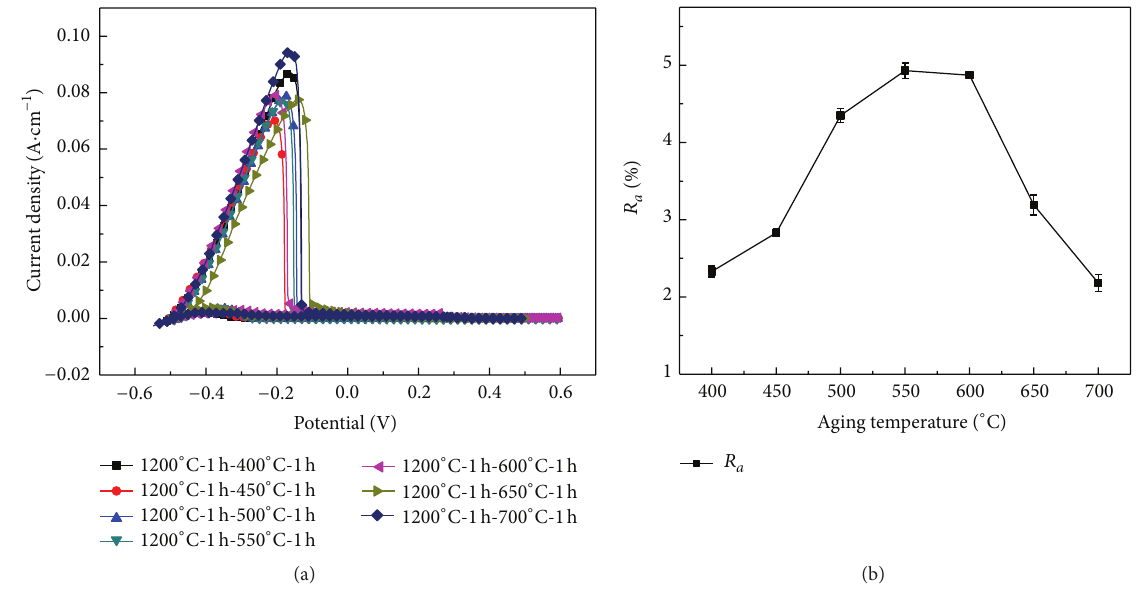
Figure 8: DL-EPR curves and 𝑅 𝑎 values of FSS 429 aging at 400–700 ∘ C for 1